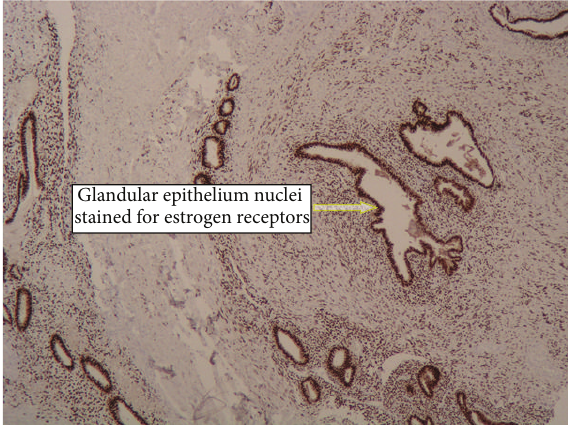
Figure 2: Darkly brown stained nuclei of epithelial cells of endometriosis foci show positive reaction for estrogen receptors. IHC staining for Rer. Magnification 120x.